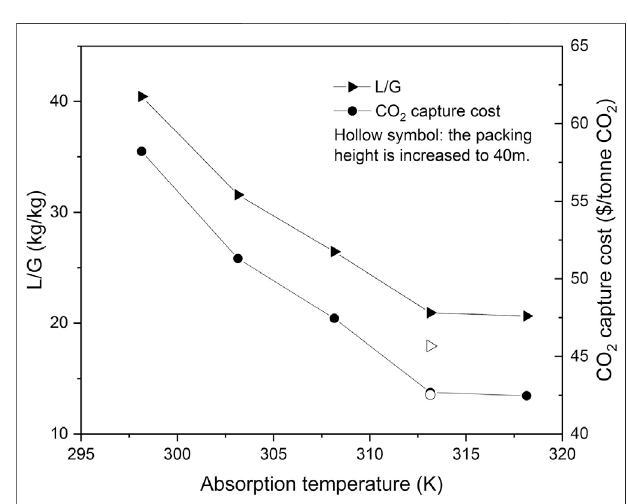
FIGURE 6 | L/G ratio and CO 2 capture cost at different absorption